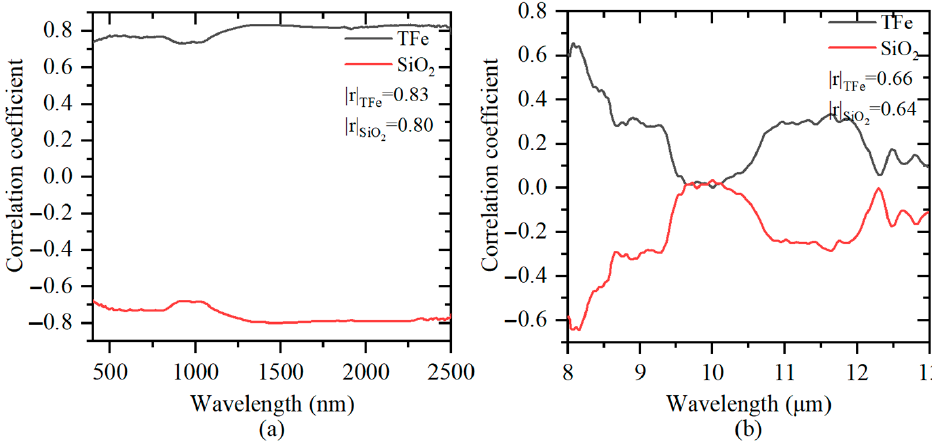
Figure 7. Correlation of VIS–NIR ( a ) and TIR ( b ) data with TFe and SiO 2 . Here, |r| was the absolute value of correlation coefficient.